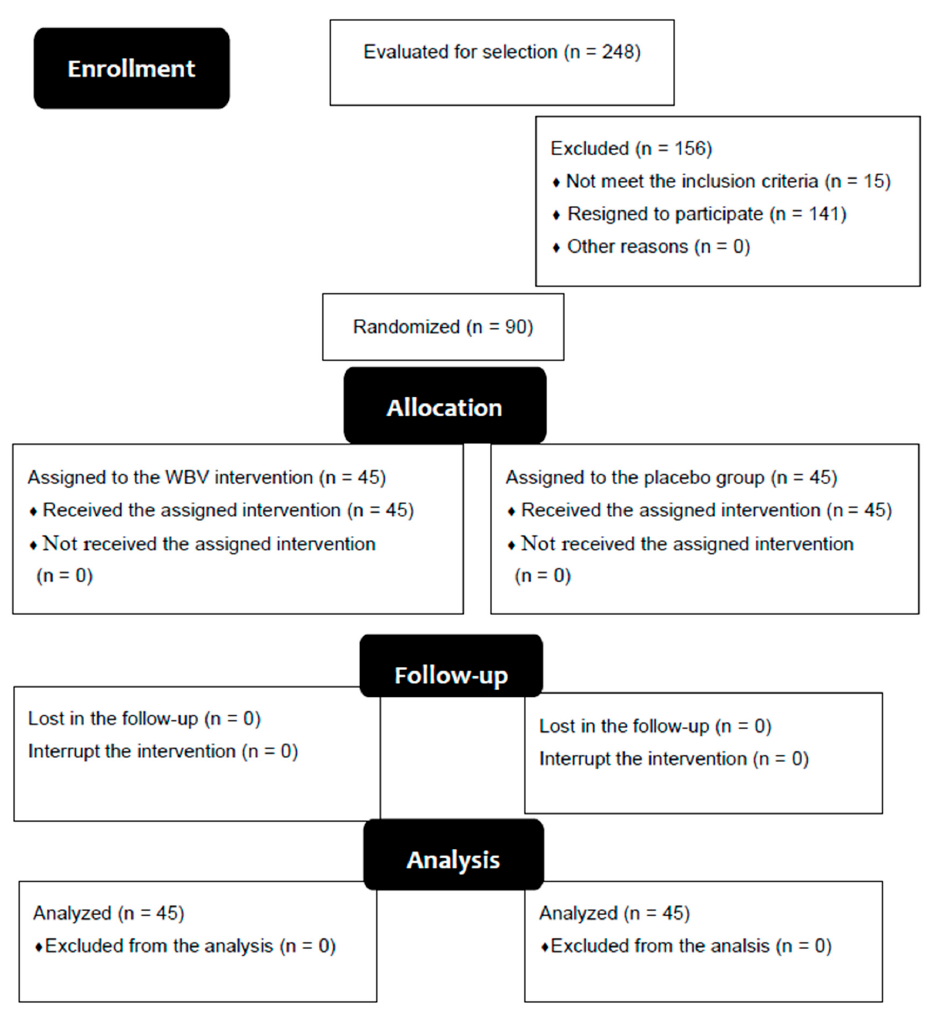
Figure 1. Flow Figure 1. Flow diagram.